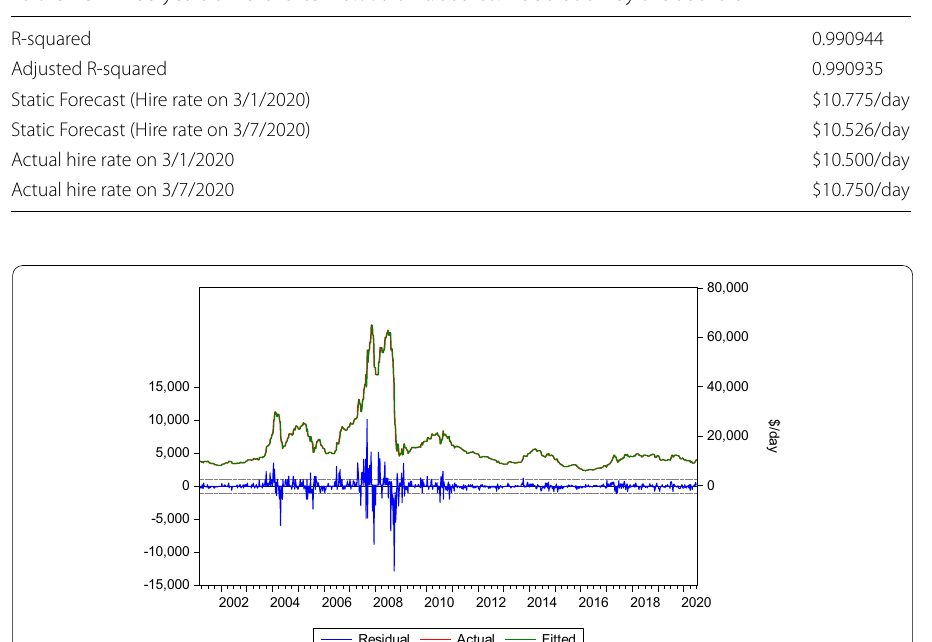
Fig. 11 Three-year time-charter 75.000 dwt. Source : Elaboration by the